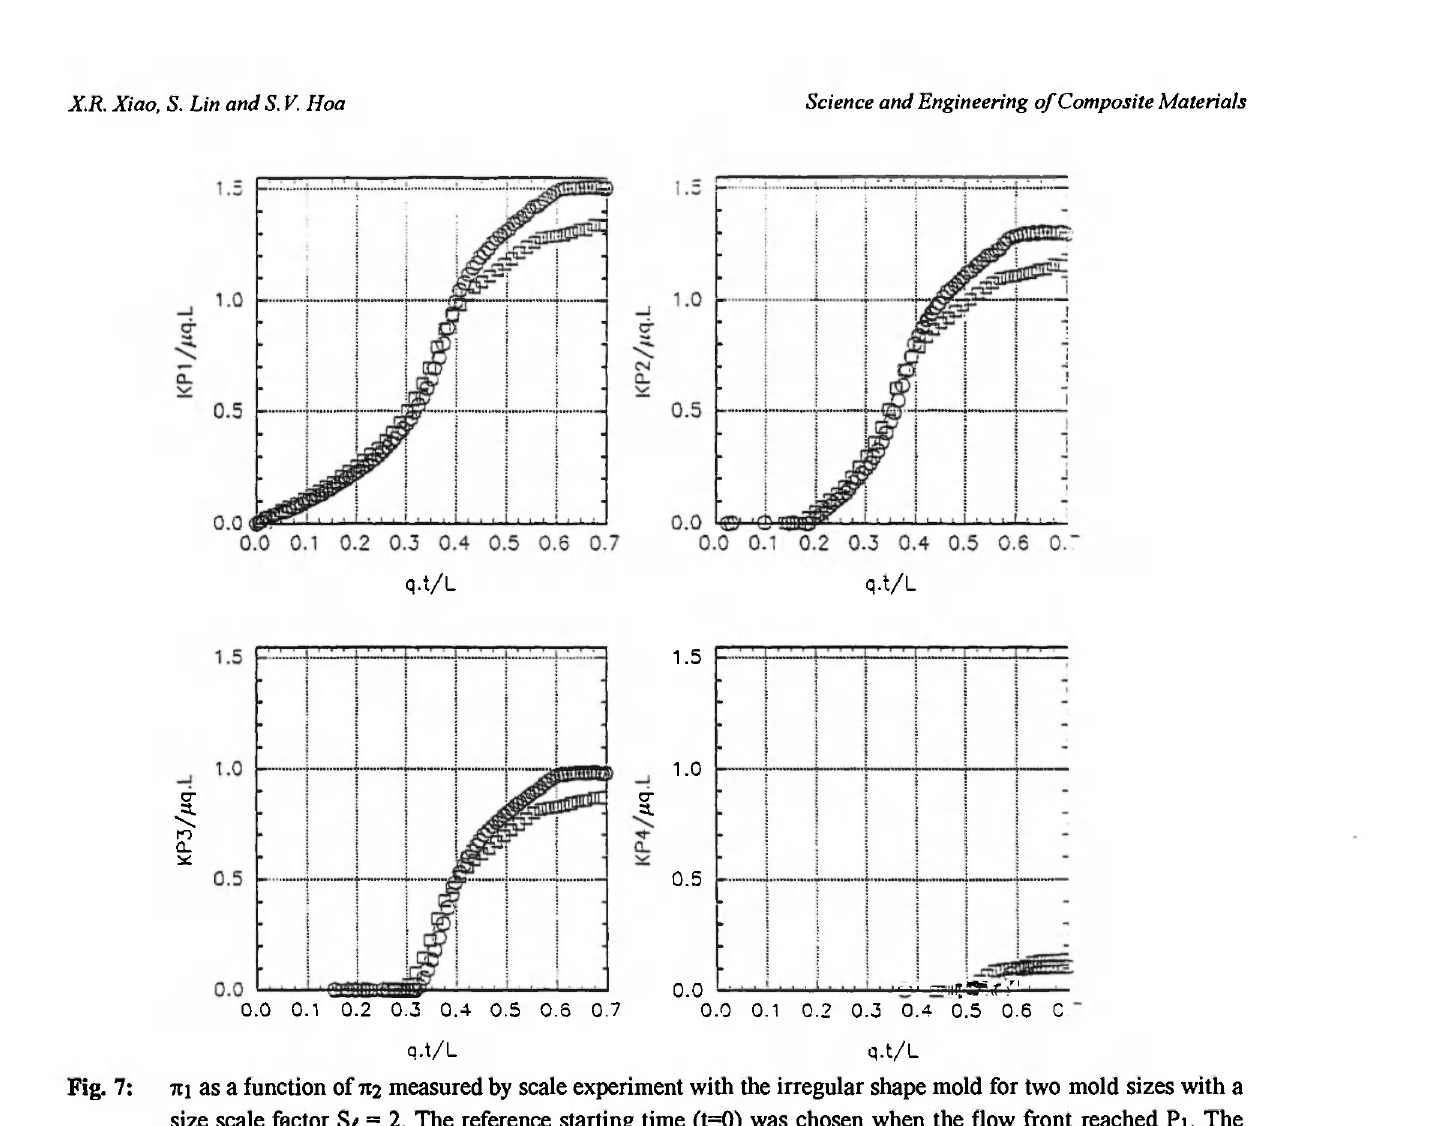
πι as a function of it2 measured by scale experiment with the irregular shape mold for two mold sizes with a size scale factor Sι = 2. The reference starting time (t=0) was chosen when the flow front reached Pi. The pressure was measured at point (a) Pi; (b) P2; P3 (d) P4, ( •) for the large mold and (O) for the small